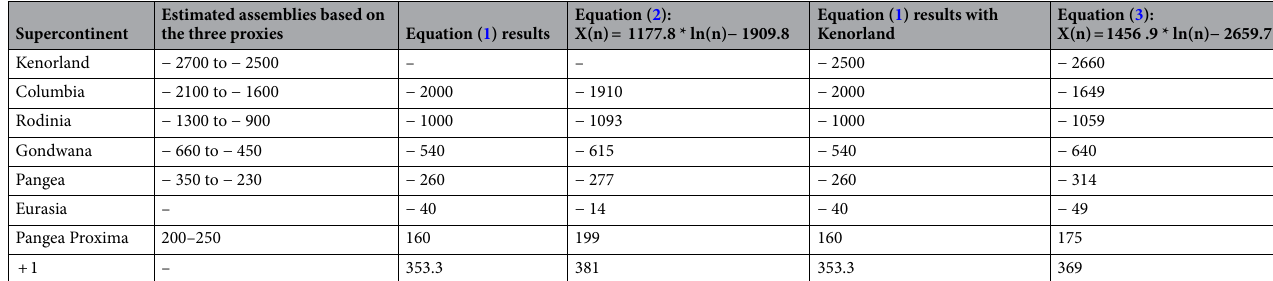
Table 3. Error assessment for mathematical equations on the prediction of supercontinent assembly (in Myr).